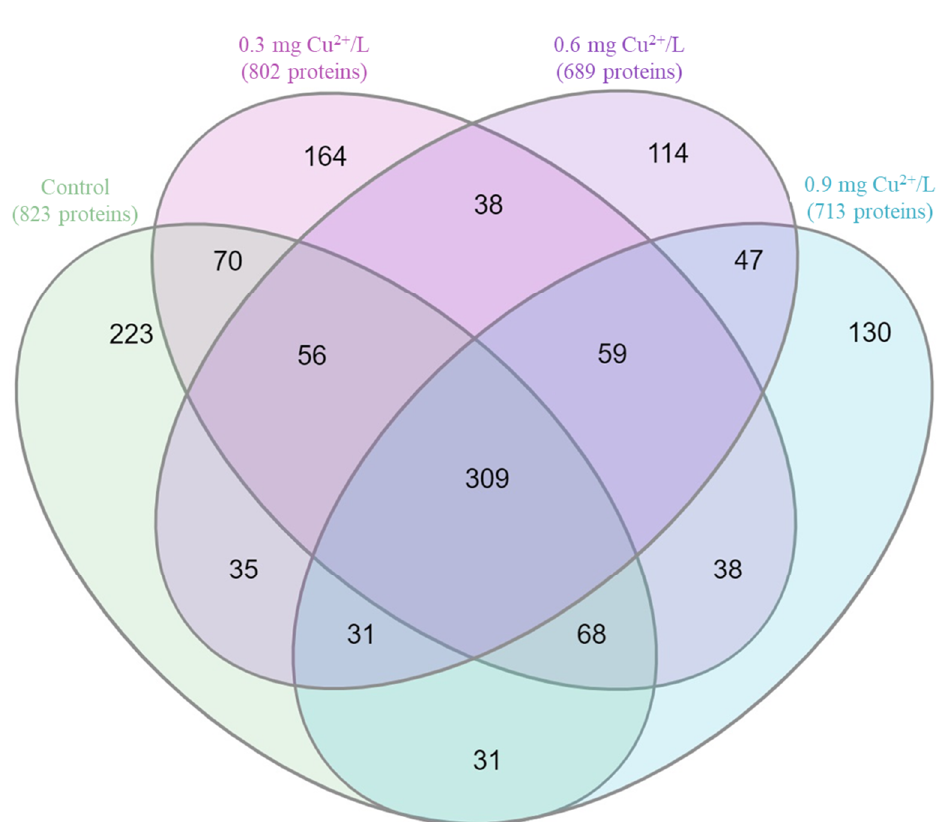
Figure 3. Venn diagram of identified proteins from control and copper treatments (0.3, 0.6, and 0.9 mg of Cu +2 /L) using the Venny tool [44].